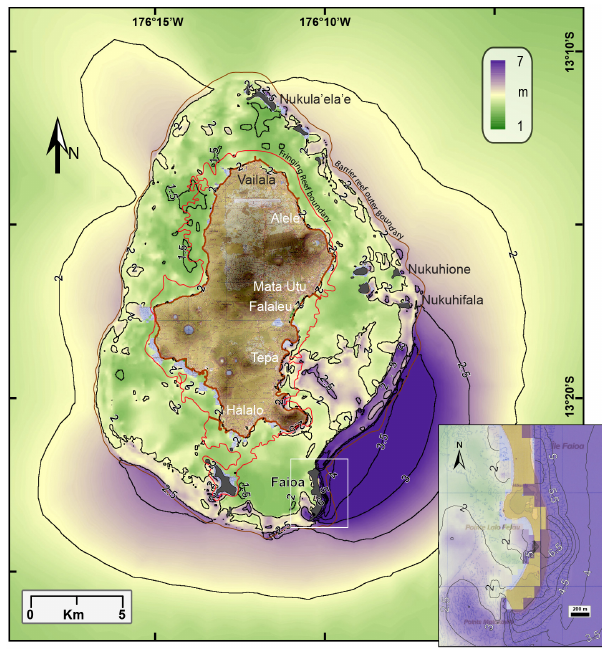
Figure 9. Maximum wave elevation (in m) at Wallis generated by an M W = 9.1 earthquake along the Tonga Trench. Model generated using the Gerris flow solver. The outer boundary of the barrier reef (brown line) and the outer boundary of the fringing reef (red line) are from ReefBase database. Insert: enlargement on the reef island of Faioa.